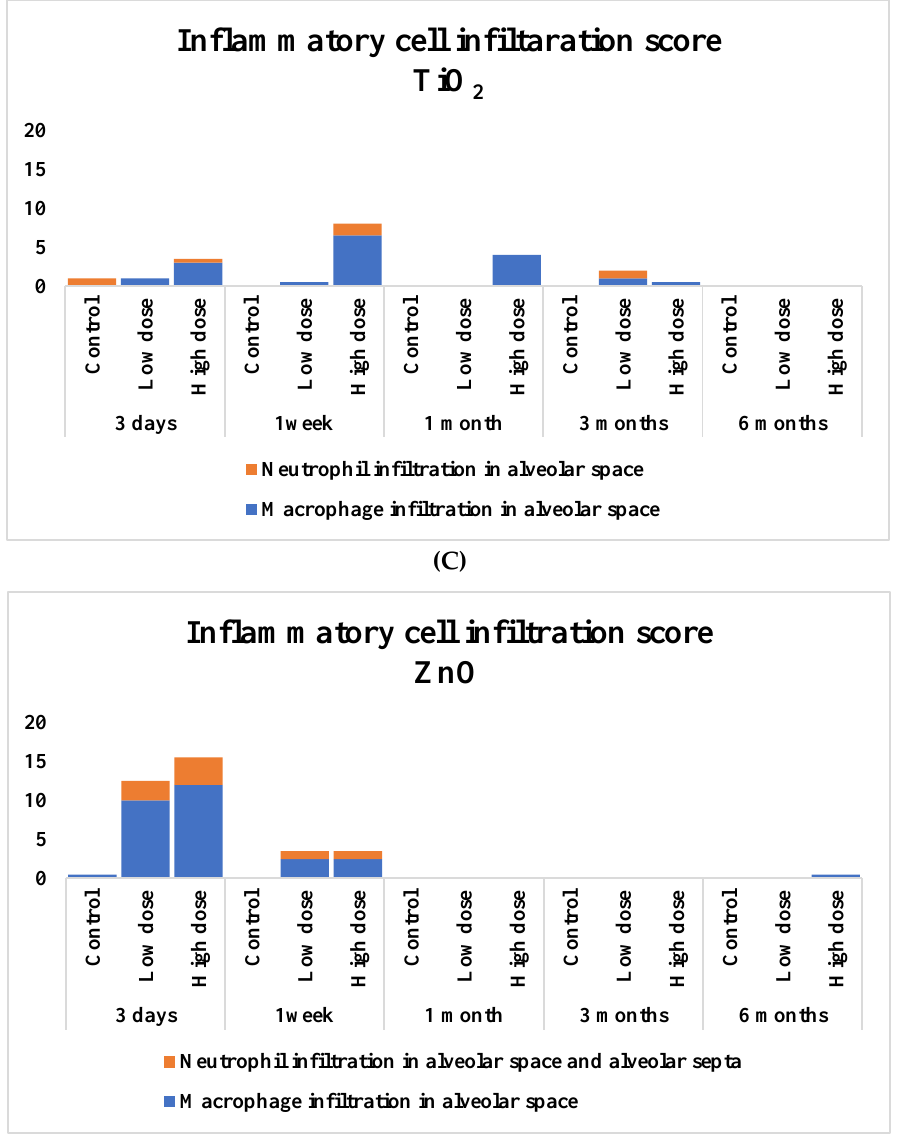
Figure 3. Score of inflammatory cell infiltration in the lung exposed to nanomaterials. ( A ) the NiO-exposed group; ( B ) the CeO 2 -exposed group; ( C ) the TiO 2 -exposed group; ( D ) the ZnO exposed-group. The severity of lung histological changes in the negative control and nanoparticle-exposed rats was scored as none (0), minimal (0.5), mild (1), moderate (2), or severe (3). Exposure to NiO and CeO 2 resulted in persistent infiltration of inflammatory cells throughout the observation period, but TiO 2 and ZnO only showed a transient infiltration. The score is calculated with a following equation. Σ (grade × number of animals with grade). The low dose groups and the high dose groups were exposed 0.2 mg 1.0 mg, respectively.